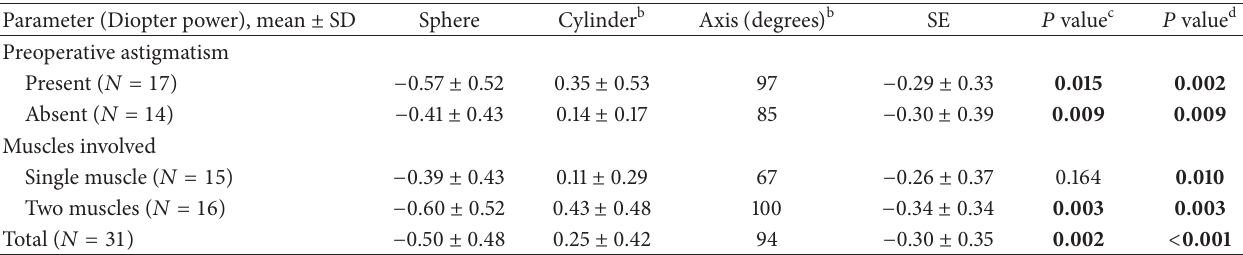
Table 3: SIRC according to preoperative astigmatism or number of muscles involved a .